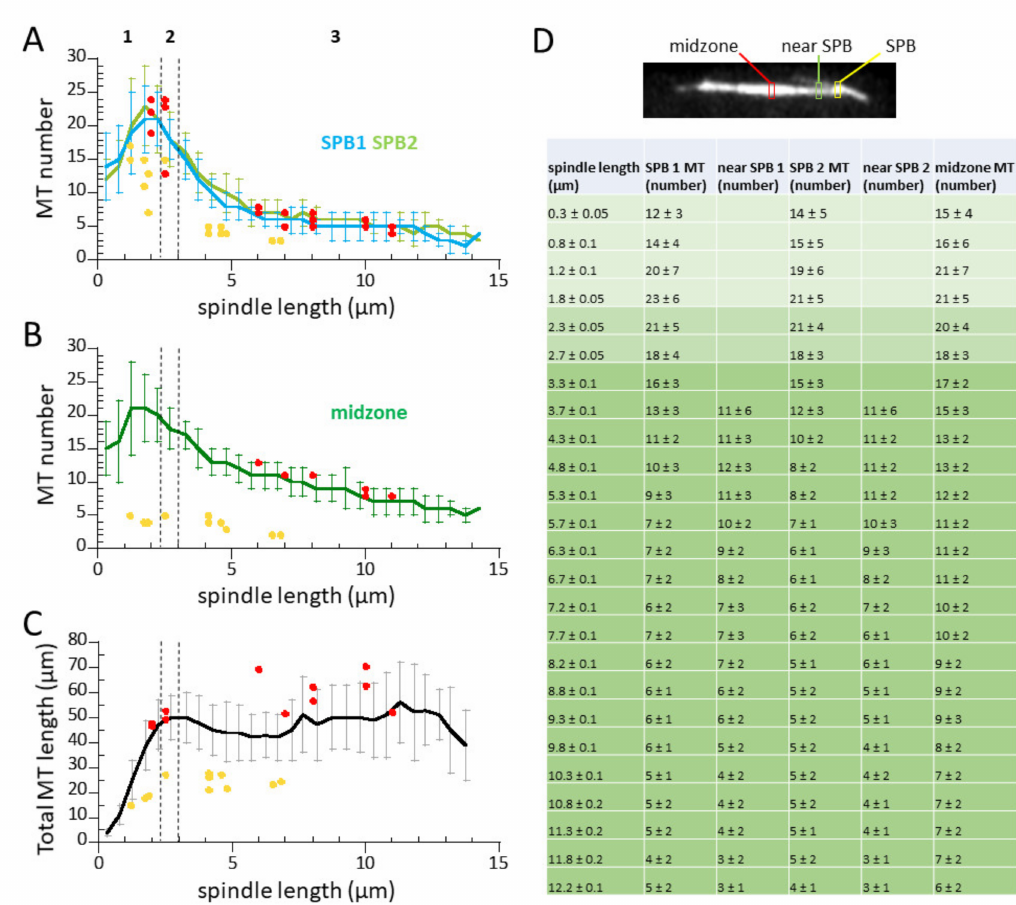
Figure 4. MT number changes throughout mitosis. ( A ) Plot of MT number versus spindle length. Shown are mean MT number ± s.d. emanating from the two SPBs (green/blue). Red dots and yellow dots represent MT number versus spindle length at the SPB measured by EM by Ding et al. [20] and Ward et al. [23], respectively. ( B ) Plot of MT number versus spindle length. Shown are mean MT number ± s.d. at the spindle midzone region (green). Red dots and yellow dots represent MT number versus spindle length at the spindle midzone measured by EM by Ding et al. [20] and Ward et al. [23], respectively. Note that the MT number obtained from quantitative fluorescent live-cell imaging (this study) matches closely with those obtained by EM by Ding et al. [20]. ( C ) Plot of total MT polymer length versus spindle length. Red dots and yellow dots represent total MT length versus spindle length measured by EM by Ding et al. [20] and Ward et al. [23], respectively. Note that even as MT number decreases as mitosis progresses, cells maintain a constant total MT polymer length. ( D ) Summary table of spindle MT length and number throughout mitosis. Image of mitotic cell with labels of regions of MT measurement. SPBs are defined arbitrarily as SPB 1 has the higher signal of the two